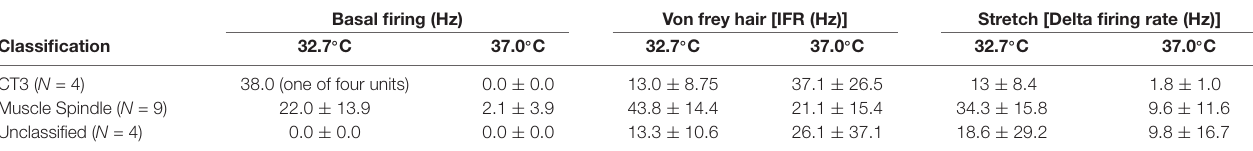
TABLE 3 | Interactions thermal and mechanical stimuli. Basal firing (Hz) Von frey hair [IFR